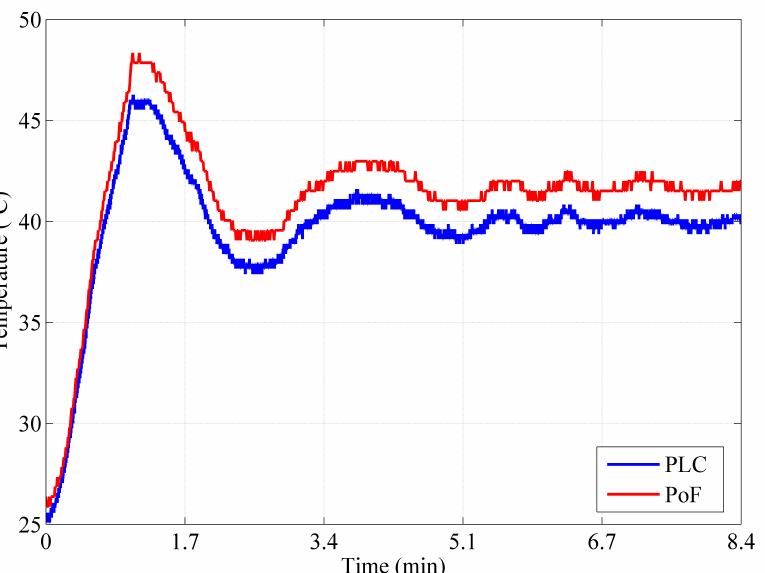
Figure 10. Temperature comparison between the PoF-based approach and the conventional industrial PLC. The temperature measurements were acquired from the TX node and sent to the optically- powered RX node (second